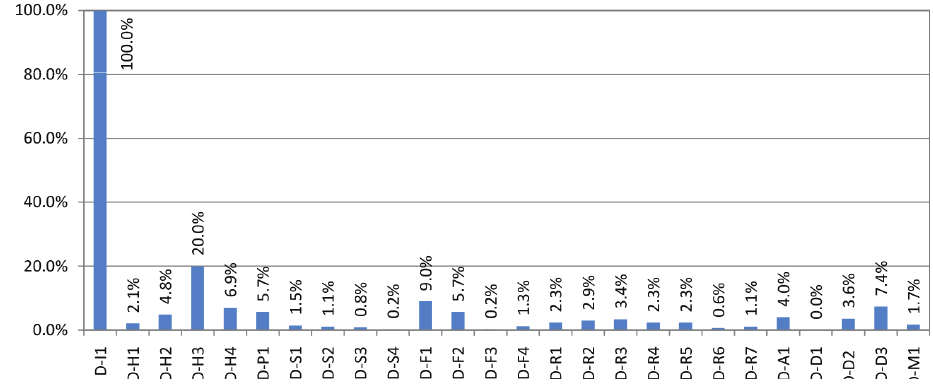
Fig. 8. Relative frequency of the diagnosis methods